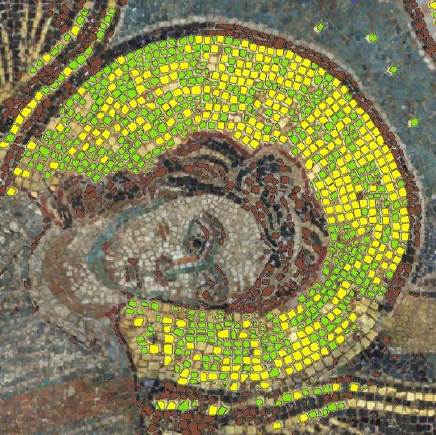
Figure 8 Segmentation, Classification and